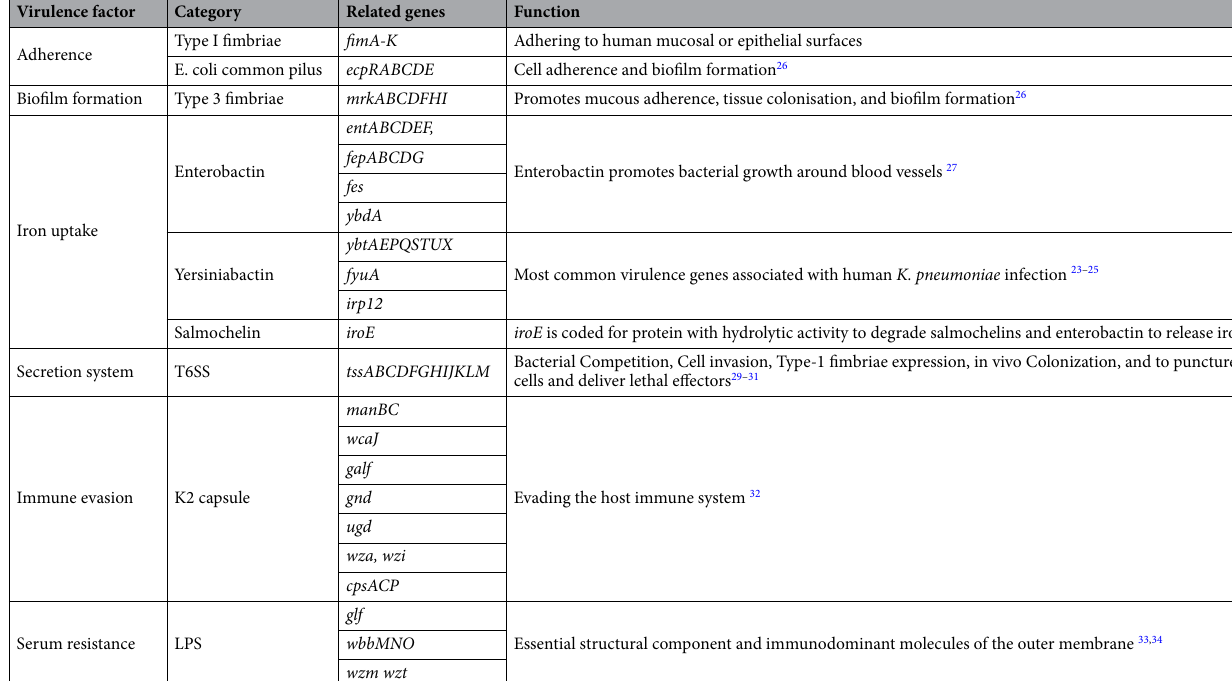
Table 3. Virulence factors in K. pneumoniae